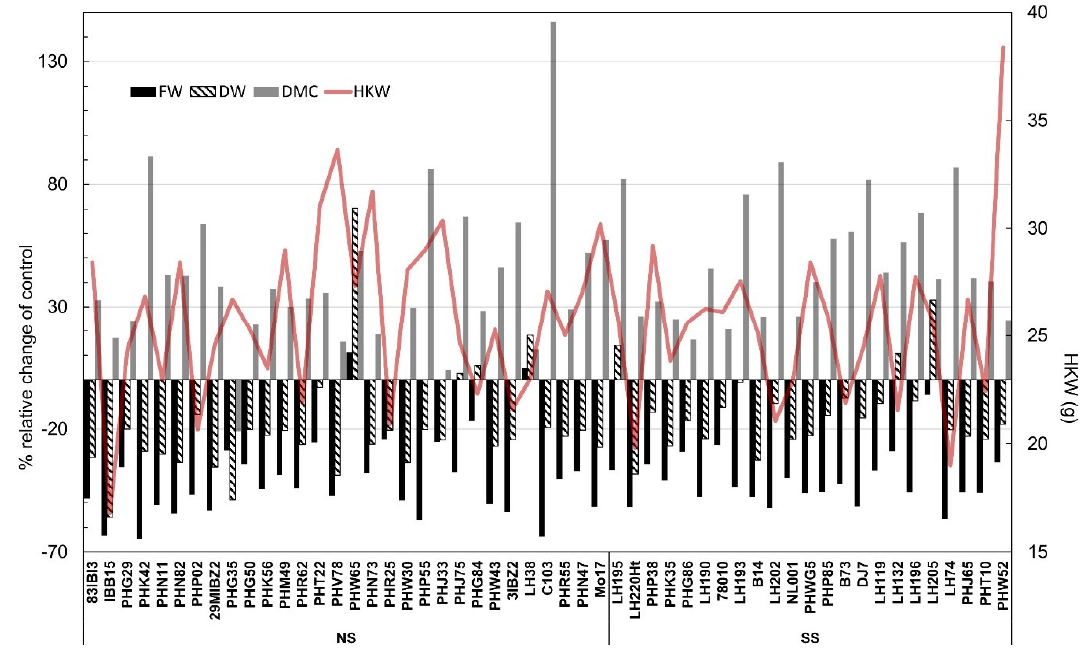
Figure 2. Relative changes in fresh weight (FW), dry weight (DW), and dry matter content (DMC) in water withholding (WW) treatment compared to control (C) of inbred lines with Q > 0.9 belonging to SS or NS genetic group (Figure 1a) along with hundred kernel weight (2nd y axis).